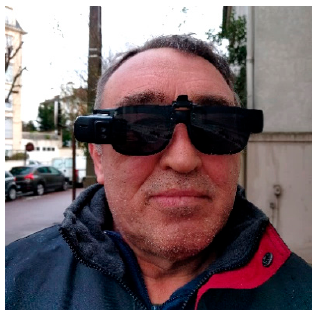
Figure 1. Participant wearing the AR glasses with additional sun windows.